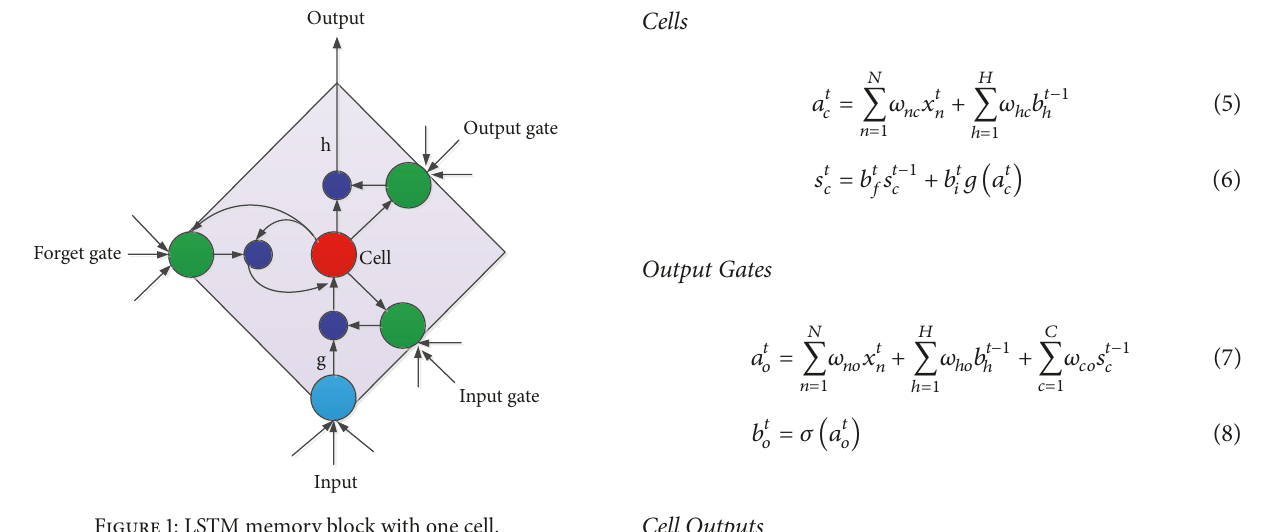
Figure 1: LSTM memory block with one